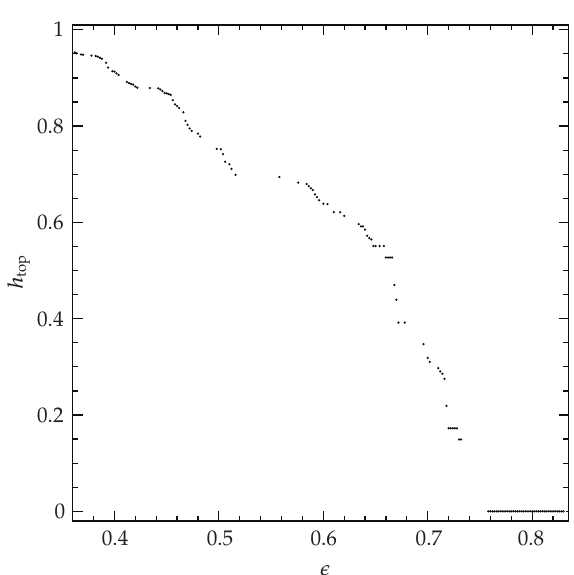
Figure 6: Variation of the topological entropy for (cid:3) ∈ (cid:5) 0 . 36 , 1 . 0 (cid:5) , with δ 2 (cid:7) 0 . 662.